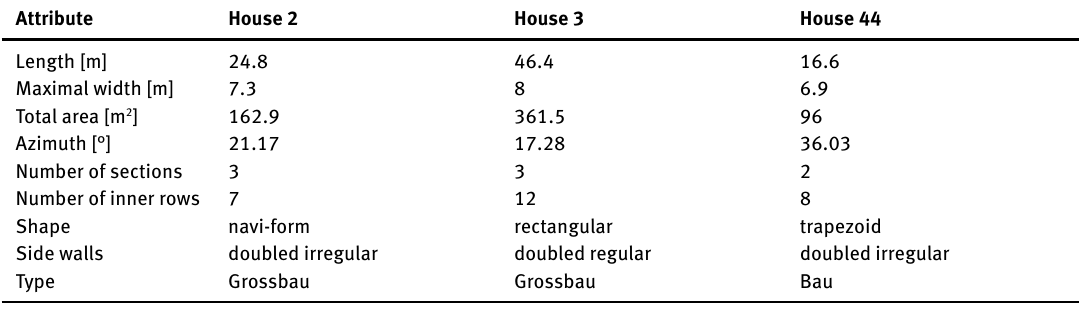
Table 4. Formal attributes of longhouse ground plans.